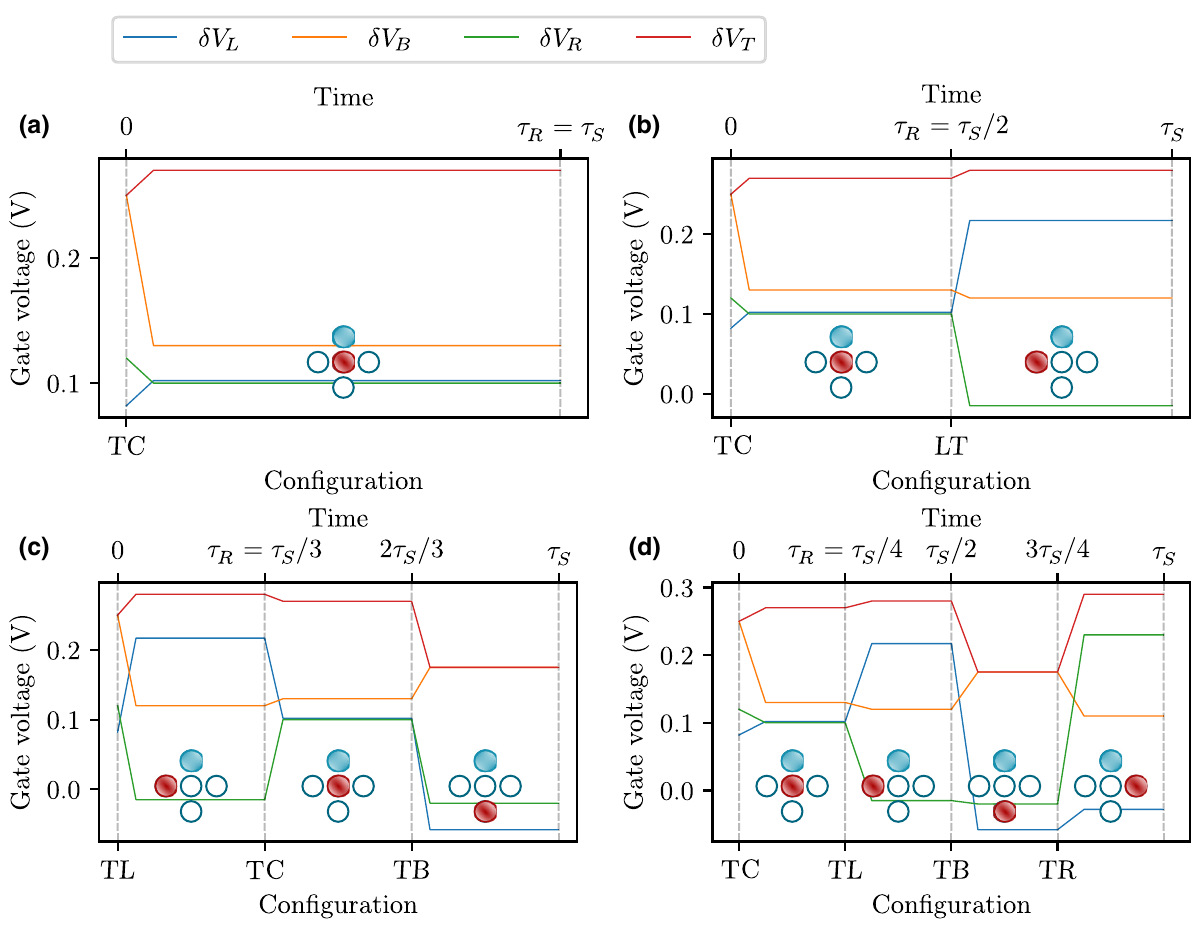
FIG. 4. Single-period electron-displacement sequences. (a)–(d) Sequences of nanosecond voltage pulses used to perform the single- period electron displacement of Fig. 3. (a) The pulses are applied during time τ S to displace the electrons in the TC configuration. (b) The pulses are applied during time τ S / 2 to displace the electrons in the TC and LT configurations. (c) The pulses are applied during time τ S / 3 to displace the electrons in the LT, TC, and BT configurations. (d) The pulses are applied during time τ S / 4 to displace the electrons in the TC, LT, BT, and RC configurations. The x -axis labels denote the location of the dot occupied by the electron. For example, “TC” denotes one electron in dot T and one in dot C . The initial and final configurations correspond to the two electrons in the C dot. The schematic representations of the charge configurations are superimposed. Only one period of displacement is shown for each sequence. The voltage rise times are given as